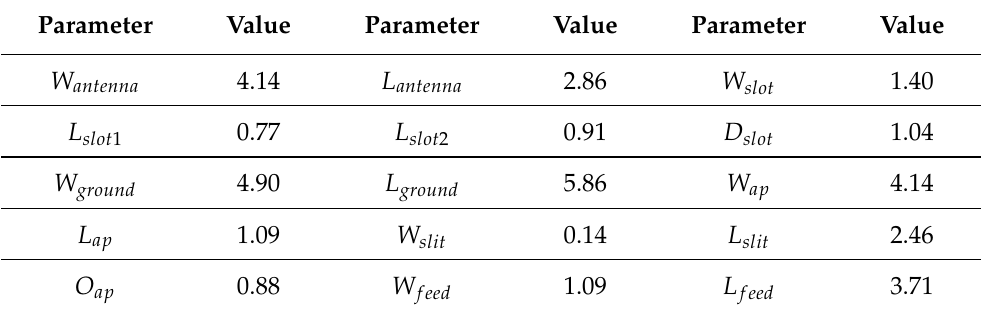
Table 7. Best values of the design parameters obtained by the WOA (all values are given in mm).